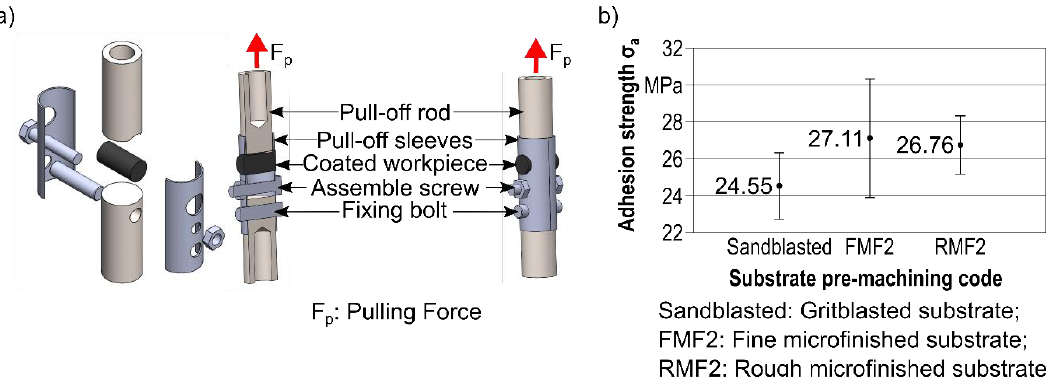
Figure 14. Adhesion test. ( a ) Schematic illustration of the test design, and ( b ) evaluation of adhesion strength.